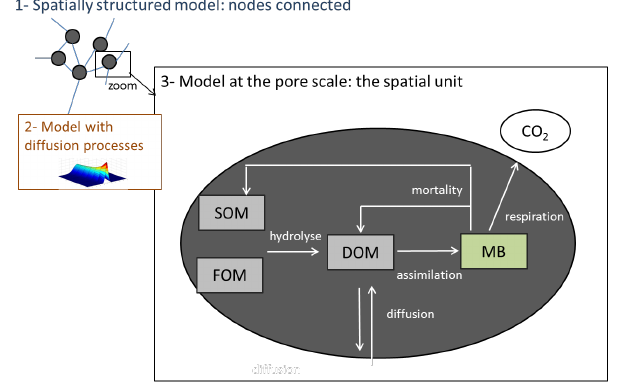
Fig. 1. Biological